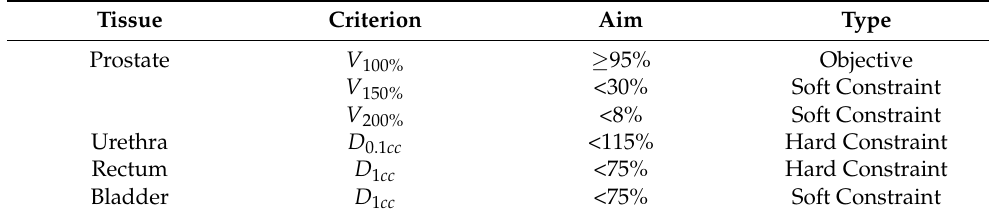
Table 2. Fraction dose objectives and constraints of the clinical HDR-BT protocol.